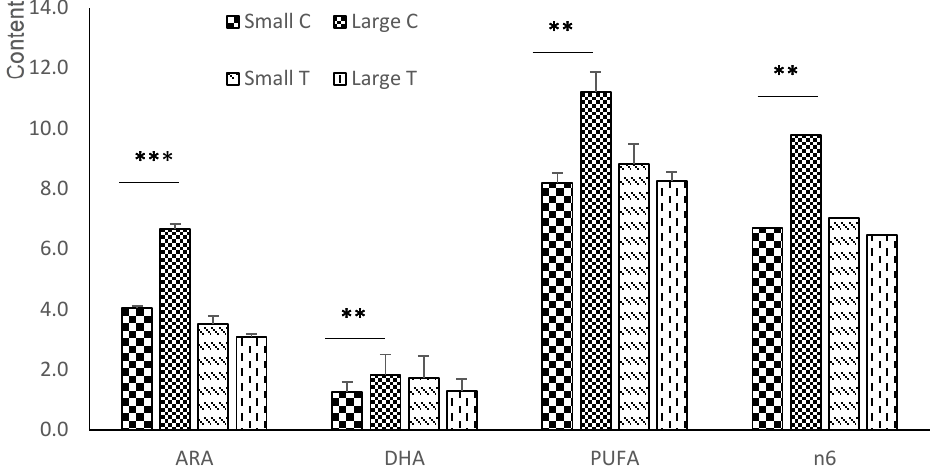
Figure 4. Treatment*litter size interactions in the n3 and n6-PUFA series of the liver between fetuses obtained at 100 days of gestation born from control gilts (group C) or from gilts treated with hydroxytyrosol and linseed oil from day 35 to day 100 of gestation (group T). ARA = arachidonic acid; DHA = docosahexaenoic acid; PUFA = sum of polyunsaturated fatty acids; n6 = sum of n6-PUFA. ** p < 0.01; *** p < 0.001.